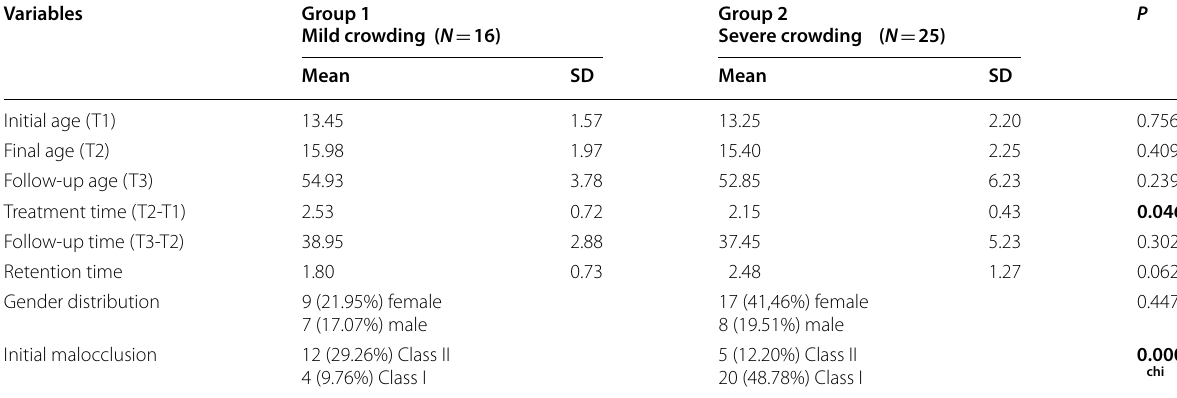
Table 1 Results of intergroup comparability of the ages, treatment, follow‑up, retention times, gender and initial malocclusion distribution (independent t test and Chi‑square test)